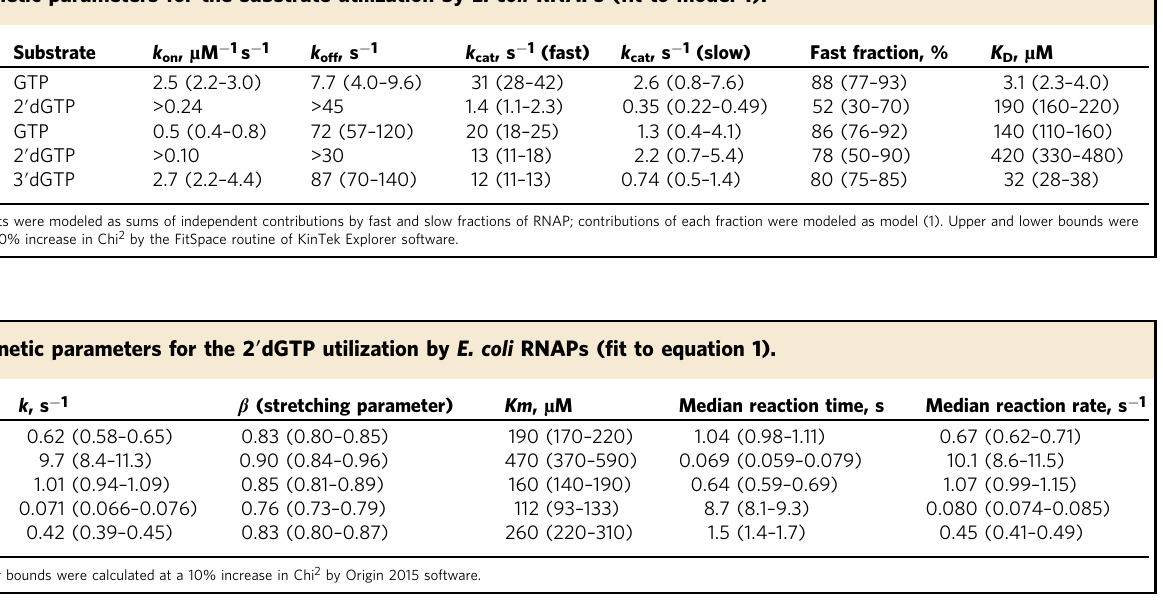
Upper and lower bounds were calculated at a 10% increase in Chi 2 by Origin 2015